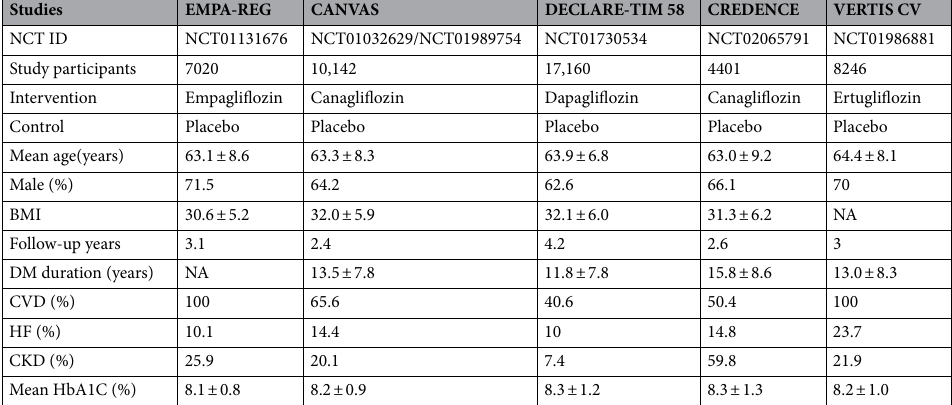
Table 1. Baseline characteristics of trials included in the systematic review and meta-analysis. BMI body mass index, CVD cardiovascular disease, HF heart failure, CKD chronic kidney disease, Hba1c hemoglobin A1c , EMPA-REG OUTCOME Empagliflozin , cardiovascular outcomes, and mortality in type 2 diabetes, CANVAS Canagliflozin and cardiovascular and renal events in type 2 diabetes, DECLARE-TIMI 58 dapagliflozin and cardiovascular outcomes in type 2 diabetes, CREDENCE canagliflozin and renal outcomes in type 2 diabetes and nephropathy, VERTIS CV Cardiovascular outcomes with Ertugliflozin in type 2